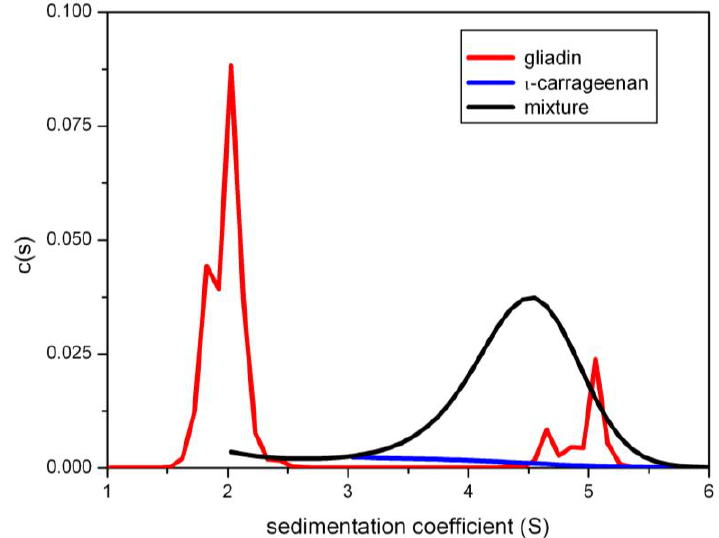
Figure 3. Sedimentation coefficient distribution diagrams for gliadins and iota carrageenan in aqueous phosphate-chloride buffer. c(s) = the population of species with a sedimentation coefficient between s and d s . UV-absorption optics at 280 nm were used showing only the gliadins—and whatever they may have interacted with. Red line: gliadin only control at 5.0 mg/mL loading concentration showing material sedimenting at 2S and a small amount of aggregated material at ~5S. Blue line: iota- carrageenan control at 1.0 mg/mL. The sedimenting material is almost transparent at 280 nm. Black line (same concentrations): mixture showing a substantial amount of material sedimenting at ~4.5S: this may indicate an interaction with gliadin. Reproduced with permission from